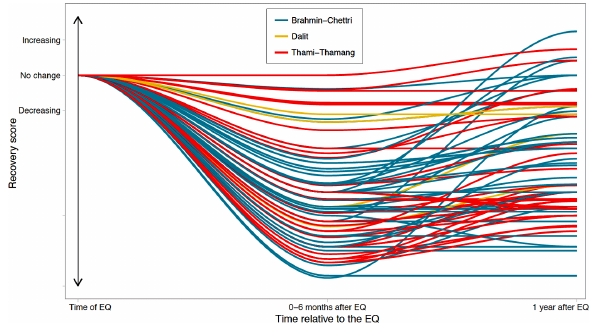
Fig. 2 . Plot of recovery assessment score trajectories for the four farming system and livelihood indicators (farm inputs and production, livestock, water and soil, and forest and pasture lands; Table 1). Each curve represents an individual respondent; n = 79. The direction and magnitude of the trajectory along the X-axis, “0–6 Months after EQ” and “1 Year after EQ,” represent an average of responses across the selected indicators. Colors represent respondent’s reported caste group: Brahmin and Chettri, Thami and Thamang, and